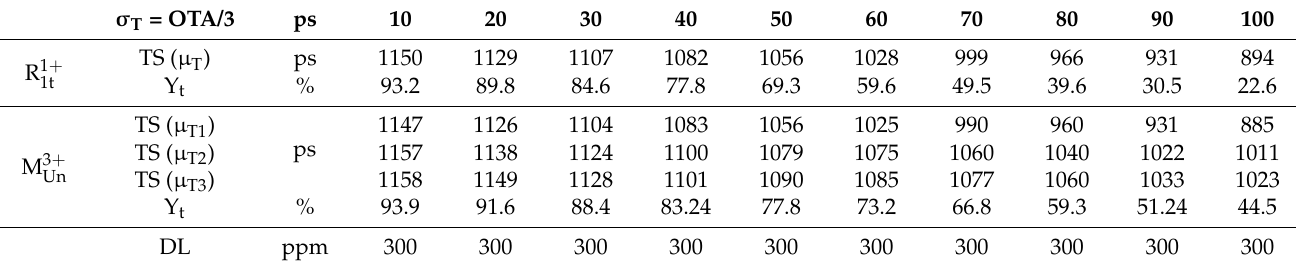
Table 3. Unbalance testing methods enhance the testing capabilities of the